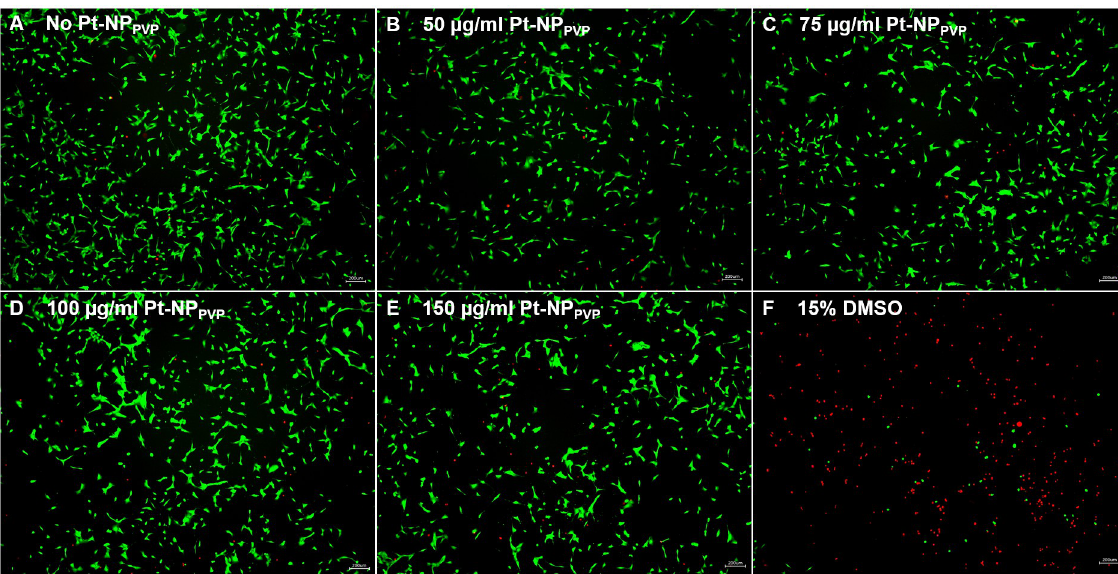
Fig 2. Fluorescent live cell staining of the HEI-OC1 cells with Calcein AM and EthDIII to distinguish between vital and dead cells following exposure to Pt-NP PVP . To distinguish between live and dead cells in the same cell population following Pt-NP PVP administration Calcein AM (green) and EthD (red) were used for live cell staining. After permeating the cell membrane Calcein AM is cleaved to calcein by the esterases in the cytoplasm which turns to the green fluorescent dye by complexing Ca 2+ -ions. In contrast, EthD only enters dead cells, when their plasma membrane is disrupted to intercalate between two adenine–thymine base pairs resulting in strong red fluorescence. HEI-OC1 cells cultivated under standard conditions served as reference (A). Cell culture assays exposed to 50 μ g/ml (B), 75 μ g/ml (C), 100 μ g/ml (D) and 150 μ g/ml (E) Pt-NP PVP revealed no nanoparticle induced cell death. As like in the cell culture assay without Pt-NP PVP supplementation (A) the majority of the HEI-OC1 cells demonstrated Calcein AM induced green fluorescence indicating membrane integrity and normal growth (B-E). The presence of few red stained cells were related to processes inducing membrane disruption and, thus, allowing EthD to intercalate the DNA-strands as especially demonstrated by the cell culture assay supplied with DMSO serving as negative control (F). Size of the bars: 200 μ m.